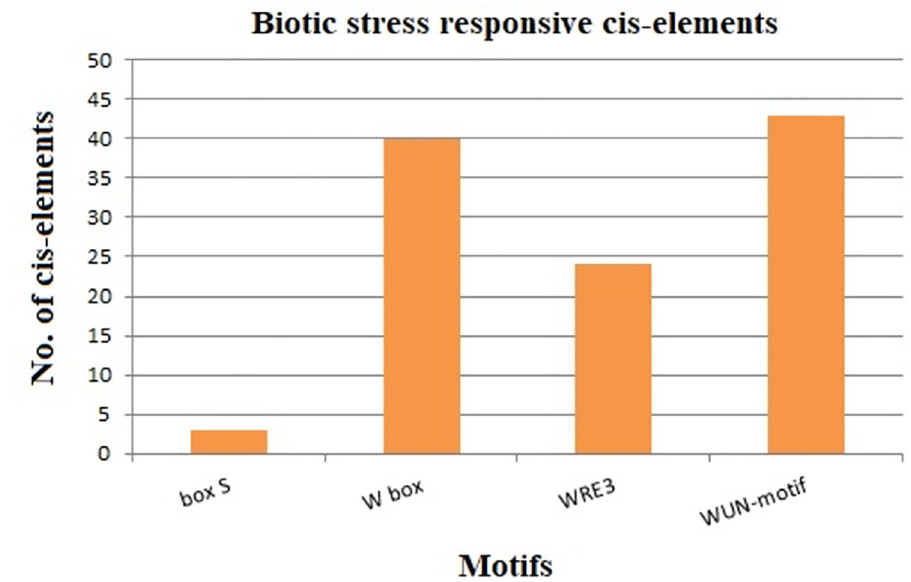
Fig 7. Biotic stress responsive elements identified in sixty-six (66) StDREB promoter regions. Results demonstrated four types of motifs involved in biotic stress responses with WUN-motif and W-box found in the highest percentage.